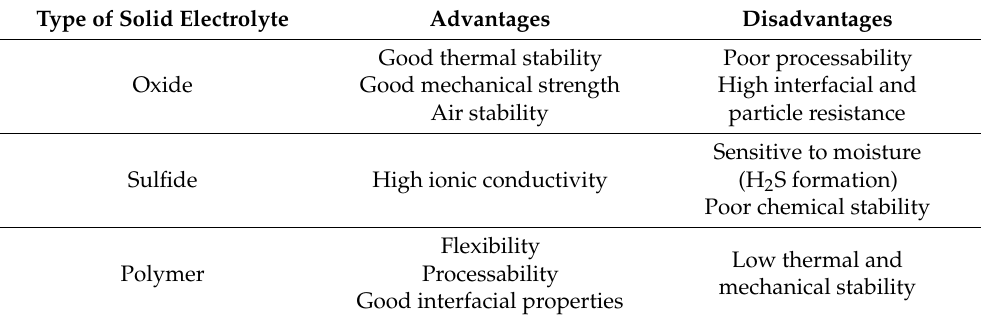
Table 1. Comparison of various solid-type electrolytes.